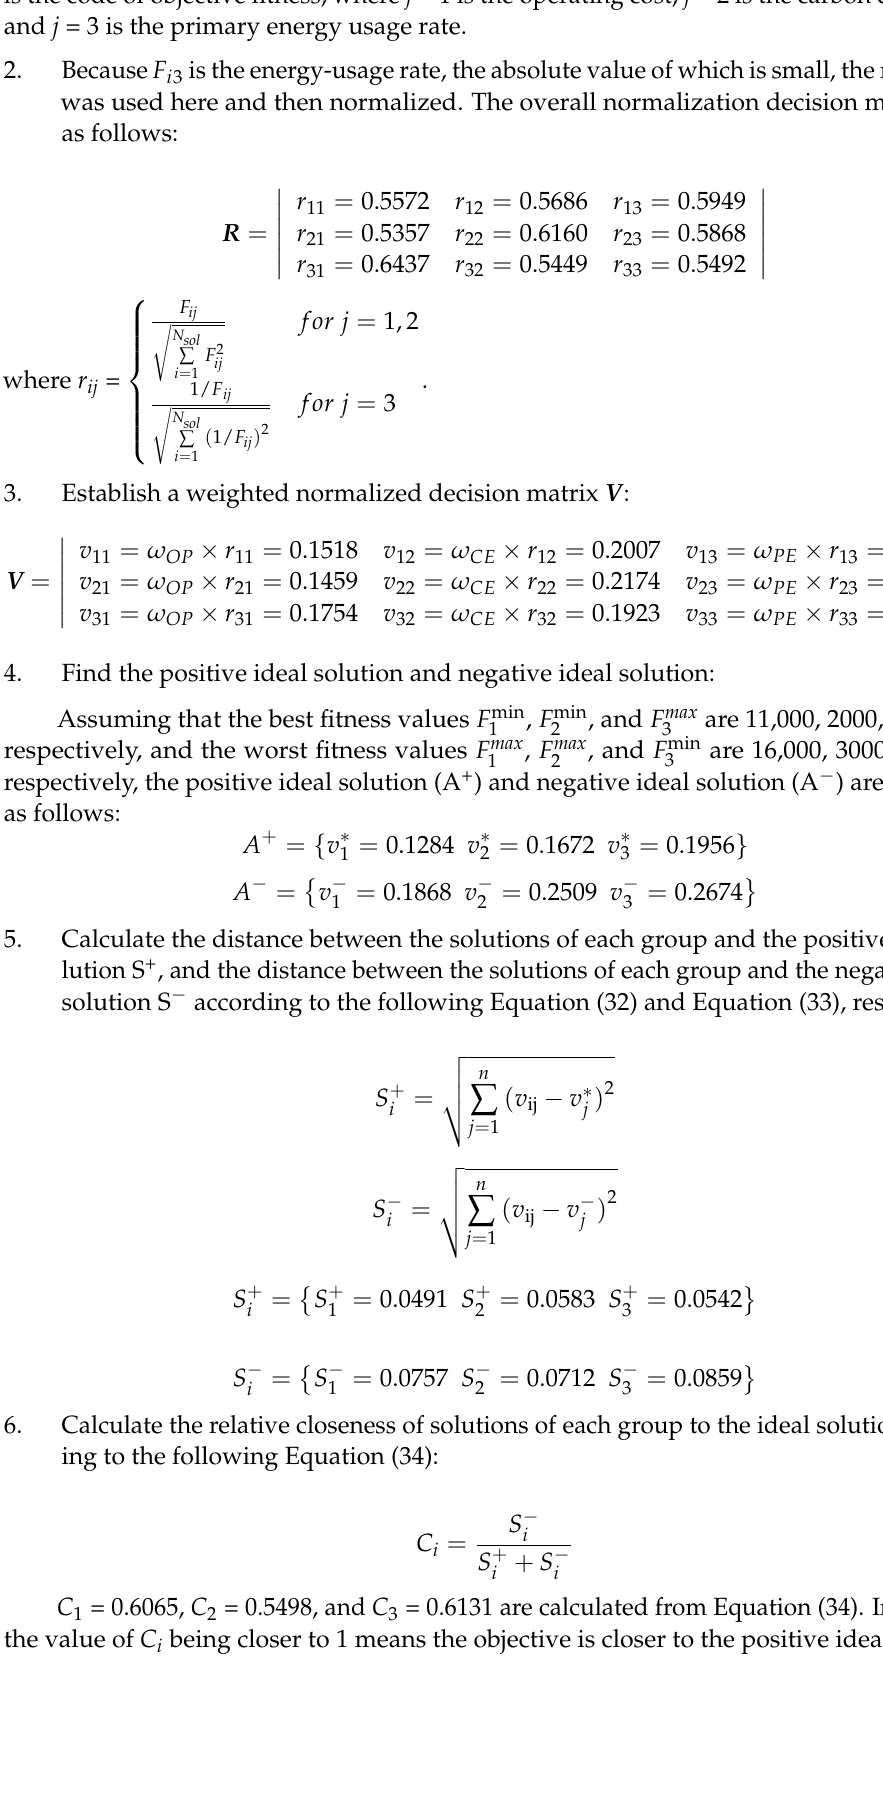
where the first subscript i of F ij is the i th group of fitness solution and the second subscript j is the code of objective fitness, where j = 1 is the operating cost, j = 2 is the carbon emissions, and j = 3 is the primary energy usage rate. 2. Because F i 3 is the energy-usage rate, the absolute value of which is small, the reciprocal was used here and then normalized. The overall normalization decision matrix R is as follows: